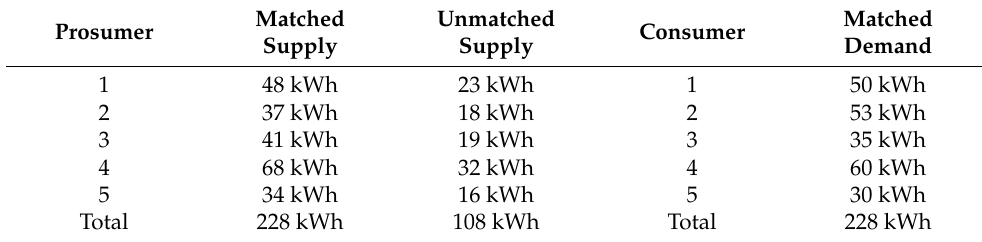
Table 6. Matching results for all prosumers and